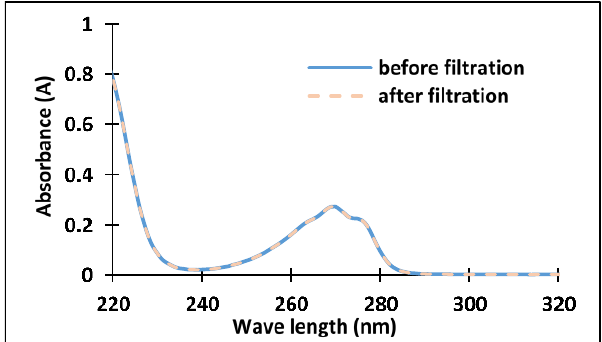
Figure 3. Absorbance spectrum of 10 ppm phenol before and after filtration using a nylon membrane filter.